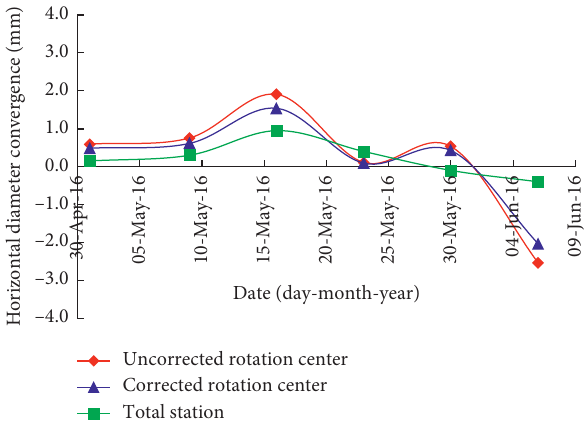
Figure 16: Variation of the tunnel’s horizontal diameter for Ring No.